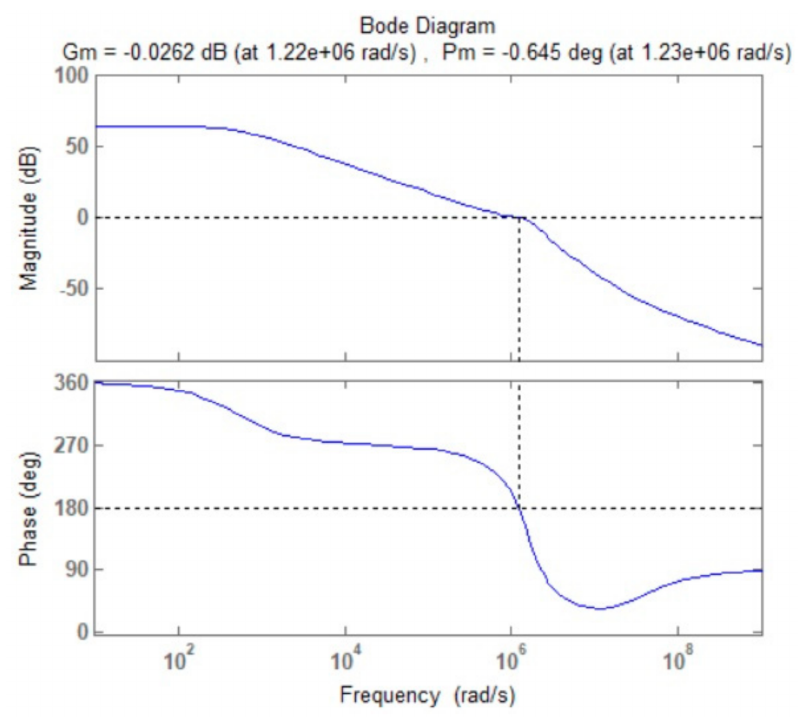
Figure 11. Bode diagram of channel 3 without